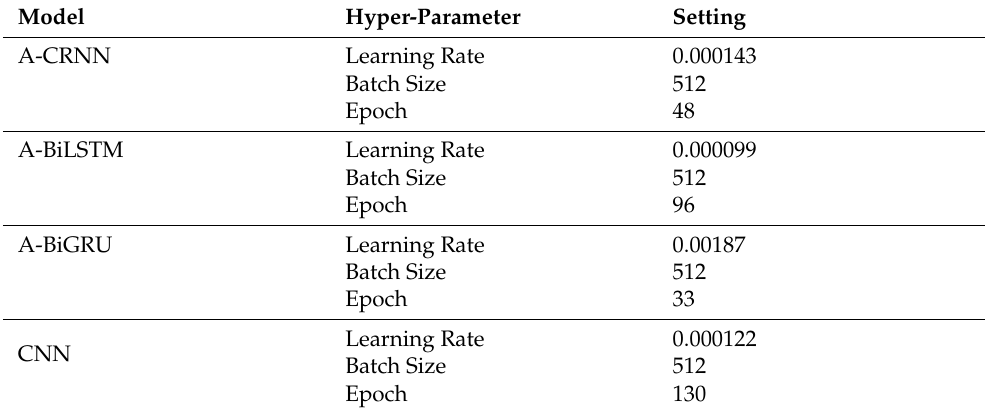
Table 11. Optimized hyper-parameter settings with respect to D3.